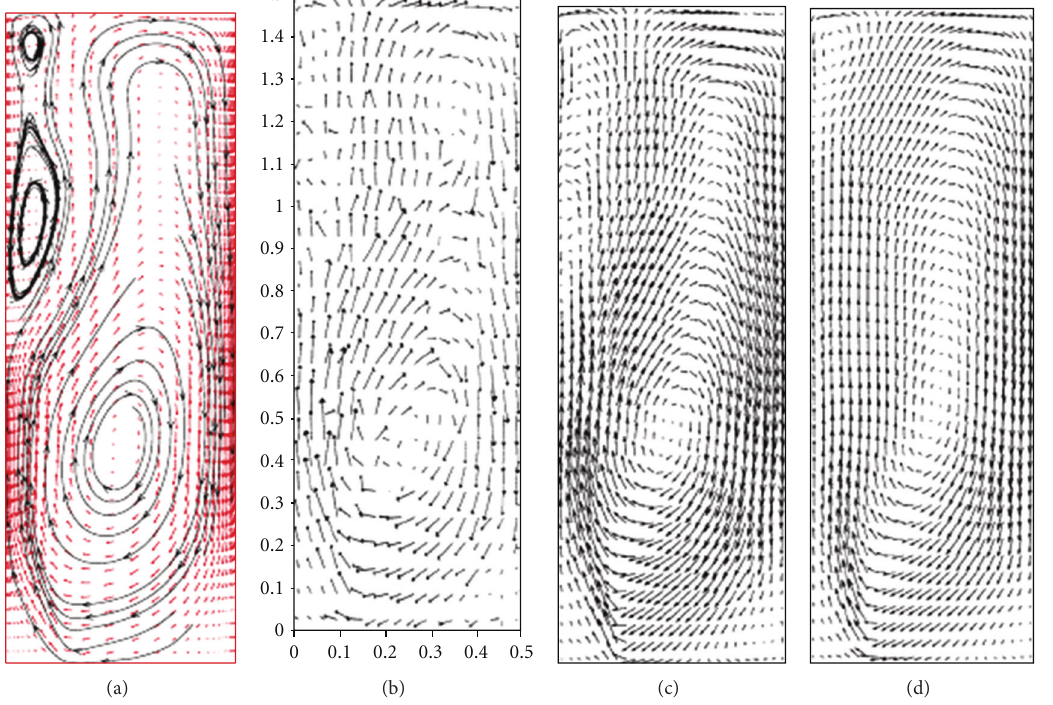
Figure 11: Long-time averaged liquid velocity field on middepth plane: (a) E-L approach, (b) LDA measurement of Becker et al. [53], (c) LDA measurement of Sokolichin and Eigenberger [54], and (d) 3D E-E simulations of Sokolichin and Eigenberger [54] (from Hu and Celik